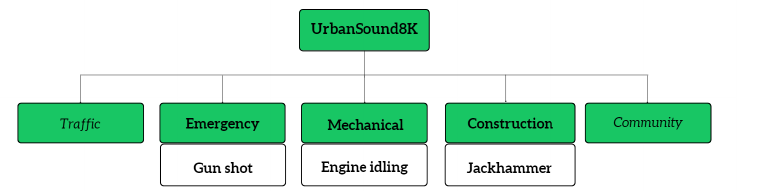
Figure 1. ESC-50 dataset.